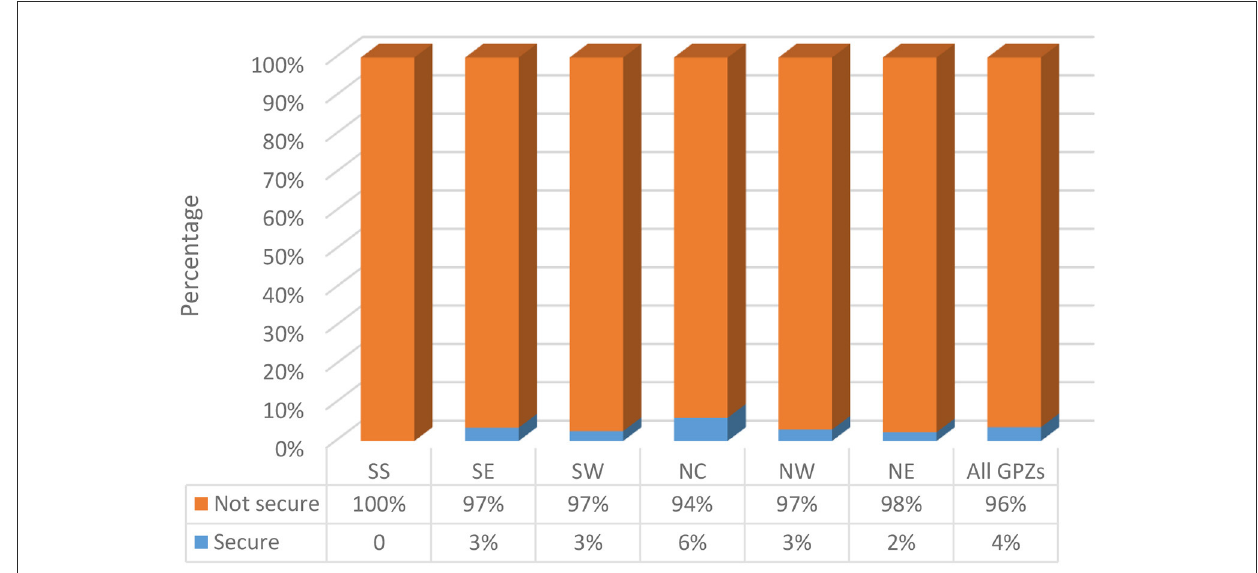
FIGURE5 Tenure Security by